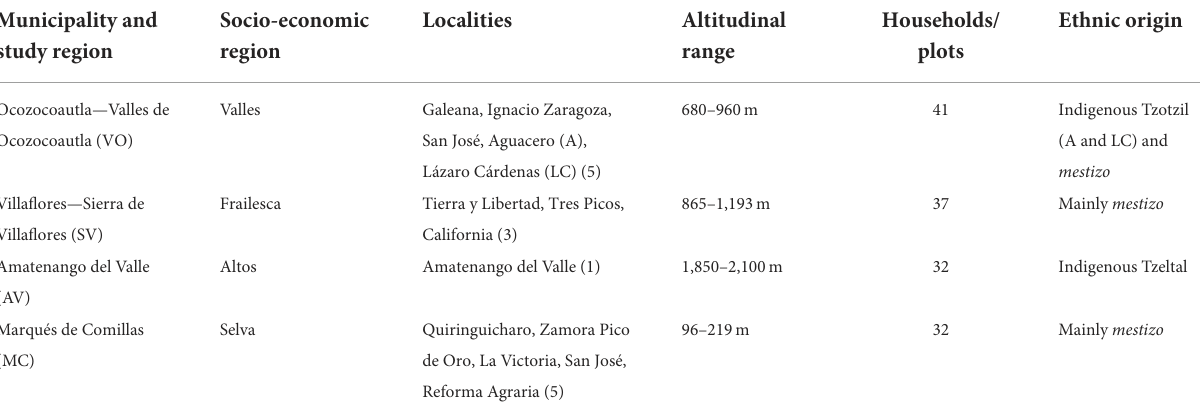
TABLE 1 General characteristics of the regions and localities within the study site. Municipality and study region region